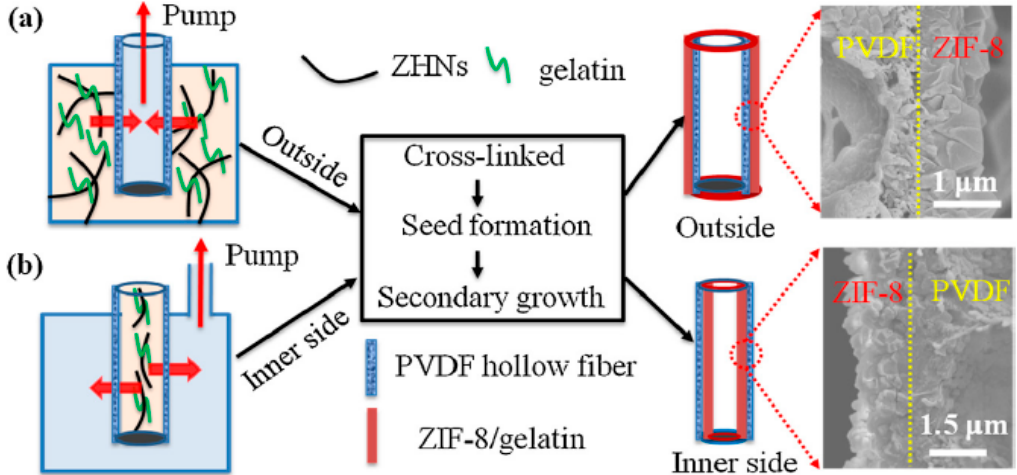
Figure 6. Schematic diagram of gelatin-assisted growth of ZIF-8 on the ( a ) outer and ( b ) inner surface of a PVDF hollow fiber with their corresponding SEM images [30].